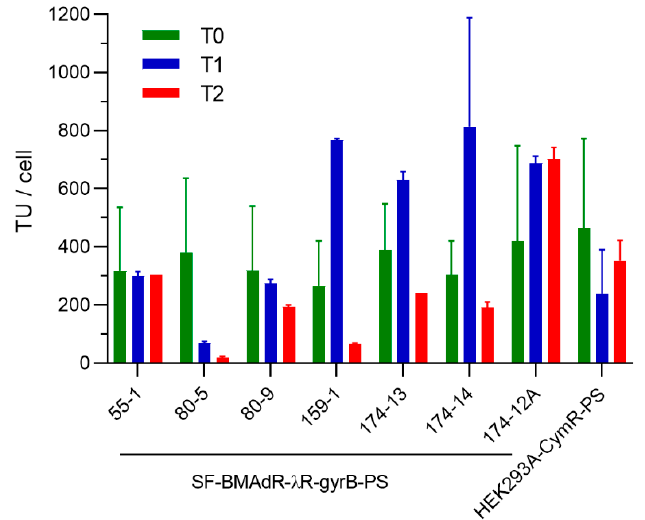
Figure 4. Stability of SF-BMAdR- λ R-GyrB-PS subclones and the HEK293A-CymR-PS pool over a period of two months. A total of 500,000 cells were infected in 24 wells in duplicate ( n = 2) with AdPS-/CU at a MOI of 5 TU/cell in the presence of coumermycin (5 nM) for SF-BMAdR- λ GyrB-PS subclones and cumate for the HEK293A-CymR-PS pool. The specific productivities of infectious vector particles (TU/cell) were determined by flow cytometry; the mean ± SEM is shown.